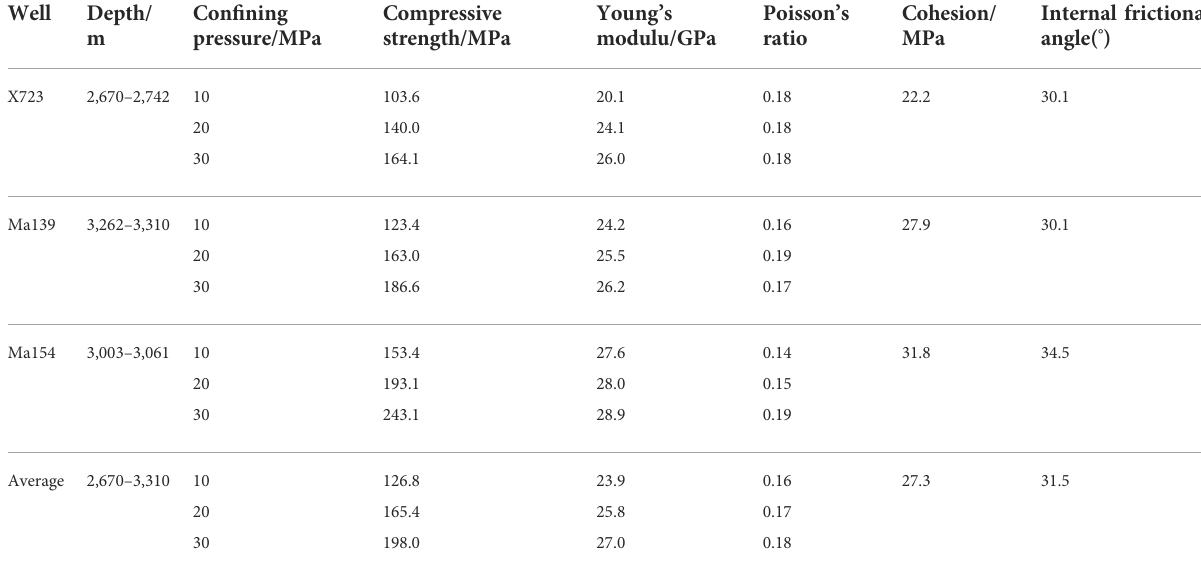
TABLE 1 Triaxial mechanical experimental data of Ma131.